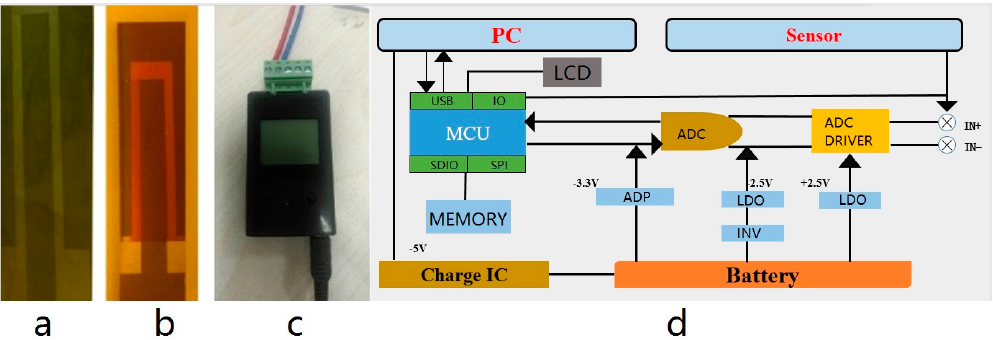
Figure 5. TFTCs sample ( a ), TFTCs sample with coating layer ( b ), post-processing instrument ( c ), post-processing logic diagram ( d ).